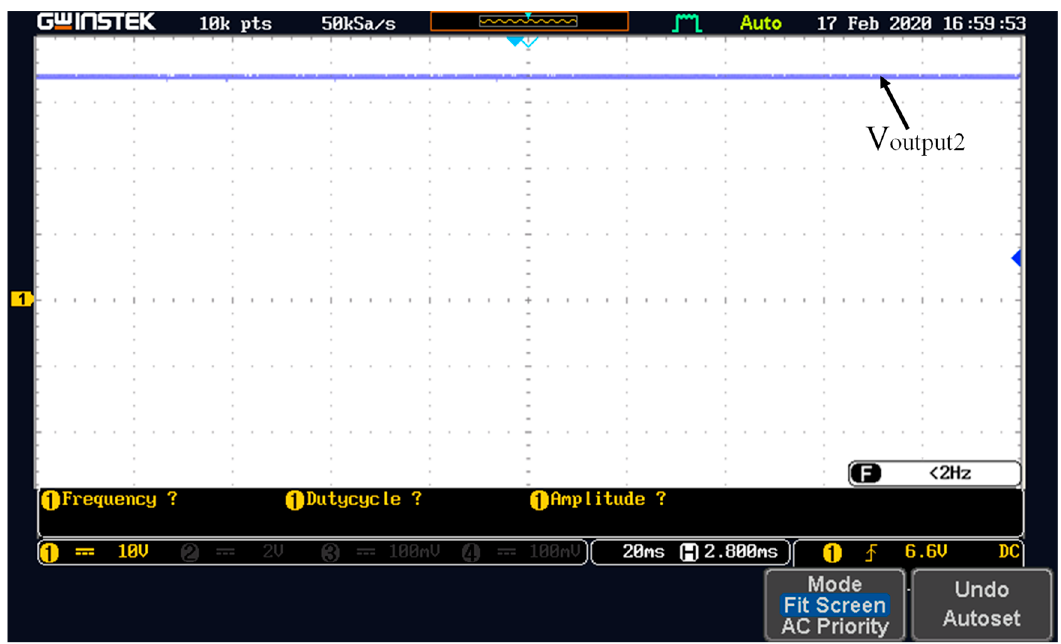
Figure 16. Switching voltage 2 waveform.